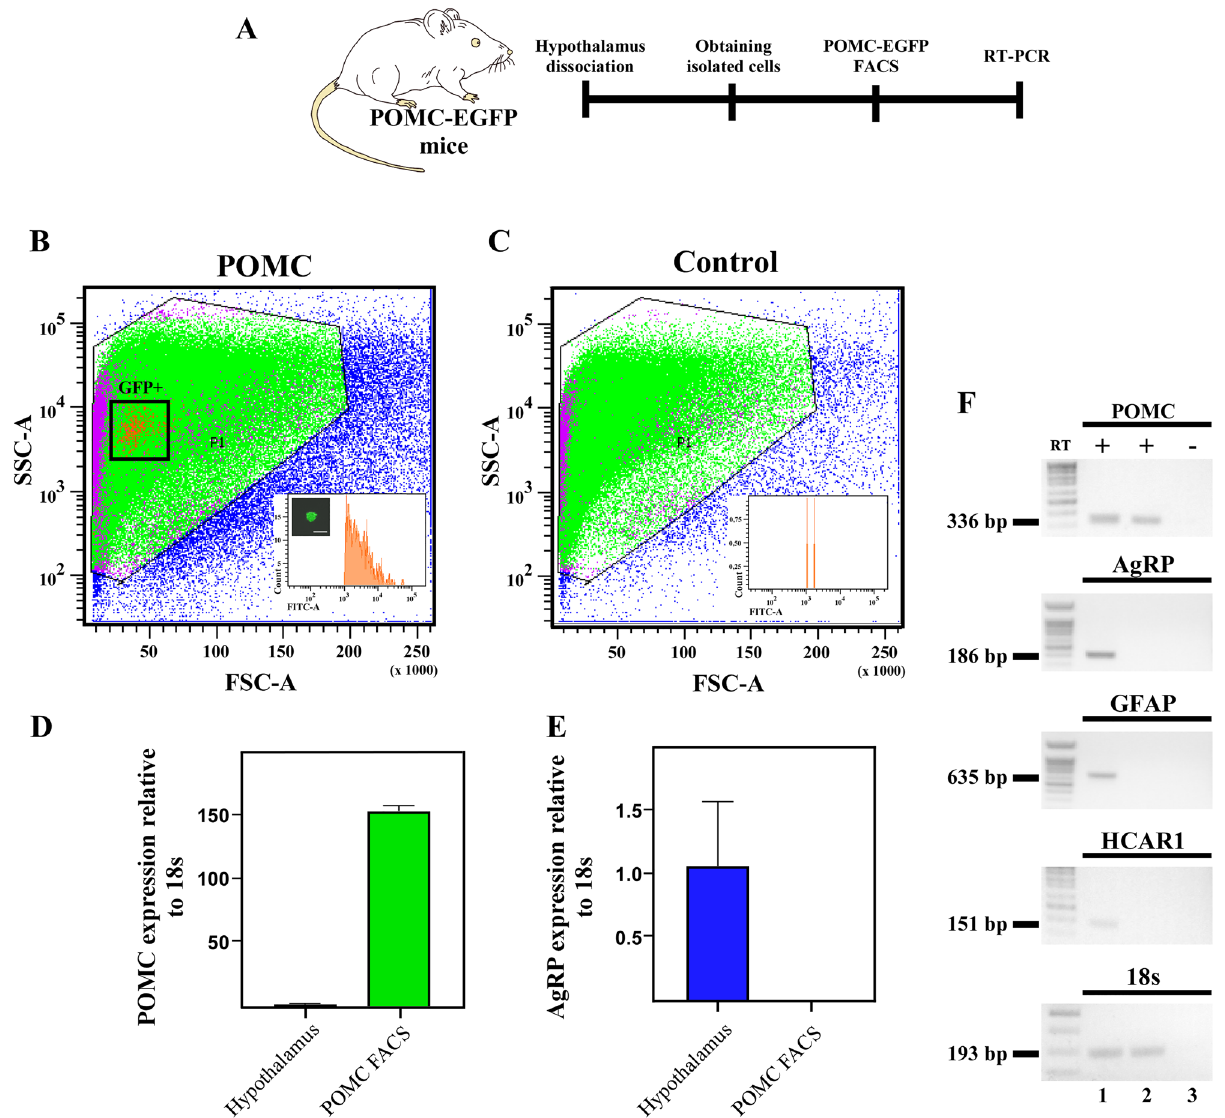
Figure 5. HCAR1 is absent of POMC neurons. ( A ) Experimental workflow. ( B , C ) Size versus cellular complexity plots from FACS purification of POMC-EGFP neurons from transgenic mice. Inserts correspond to FITC intensity distribution of sorted events. ( B ) POMC-EGFP mice. ( C ) WT control mouse. ( D , E ) qRT-PCR of hypothalamus samples and sorted POMC neurons in POMC-GFP mice (N = 3). ( F ) Expression profiles of Pomc, Agrp, Gfap, Hcar1 and 18 s ribosomal RNA from hypothalamus samples (lane 1), sorted POMC neurons (lane 2) cDNA, RT (−) of sorted POMC neurons (lane